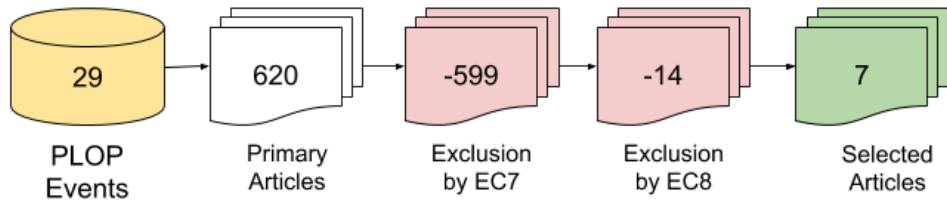
Figure 4. Manual search